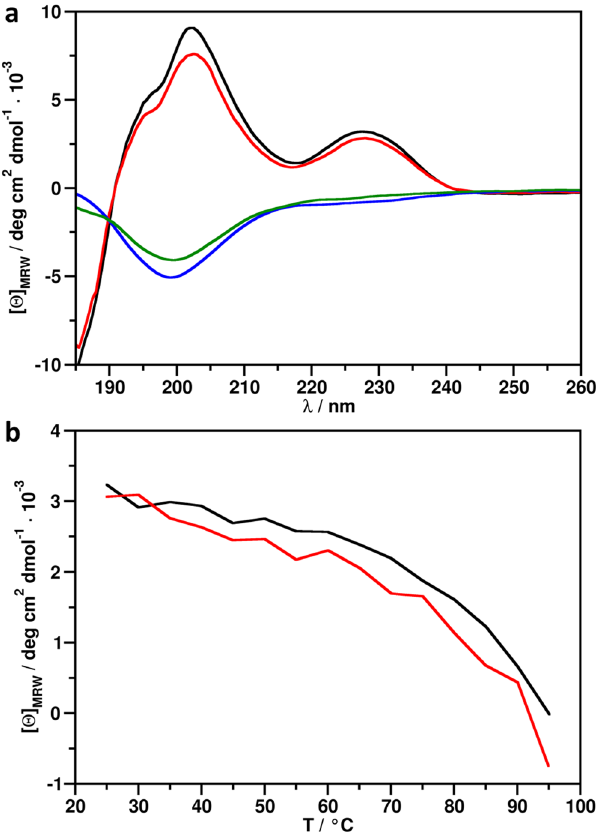
Figure 3. ECD spectra and thermal unfolding of NFAP, NFAP Δ h, and NFAP Δ N. ( a ) ECD spectra of native NFAP (black), recombinant NFAP (red), NFAP Δ h (blue) and NFAP Δ N (green) mutants recorded at 25 °C. ( b ) Thermal unfolding of native NFAP (black) and recombinant NFAP (red) followed by ECD spectroscopy at 228 nm. NFAP: native and recombinant Neosartorya fischeri NRRL 181 antifungal protein; NFAP ∆ h: hydrophobic core deletion NFAP mutant; NFAP ∆ N: N-terminal amino acids exchanged NFAP